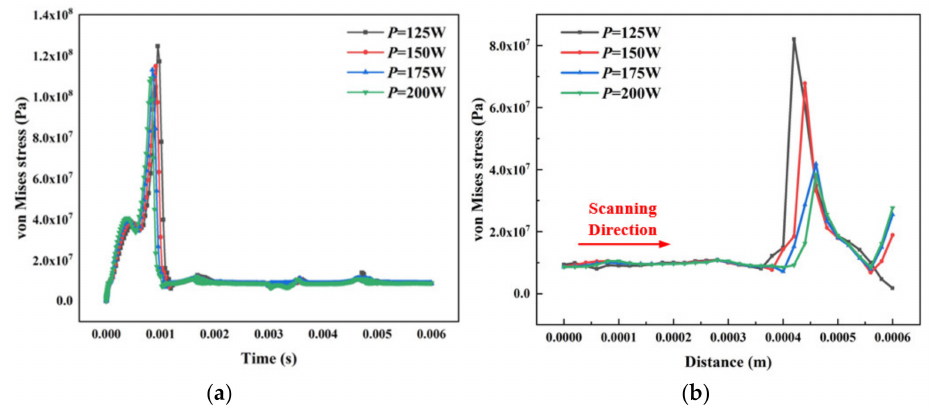
Figure 7. ( a ) Transient von Mises stress distribution through the scanning process under different laser powers. ( b ) The von Mises stress distribution at different laser powers in the same time.